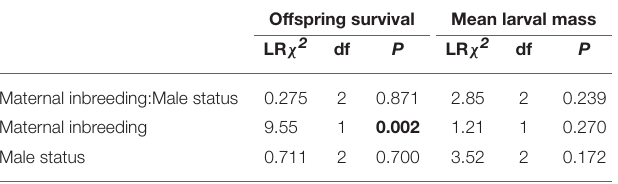
TABLE 1 | Effects of maternal inbreeding (inbred or outbred) and male status (inbred, outbred or absent) on offspring survival until dispersal and mean larval mass at larval dispersal.